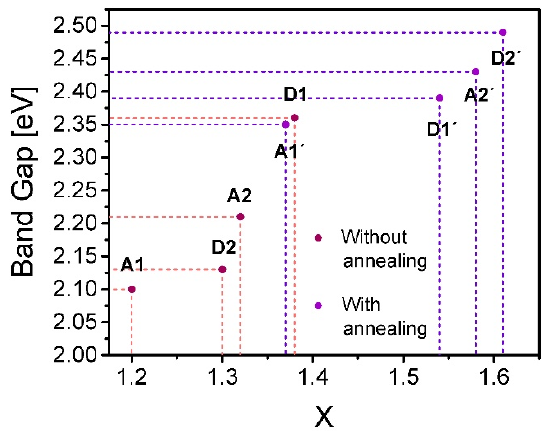
Figure 10. Correlation between the stoichiometric ratio x and the calculated energy band gap values.